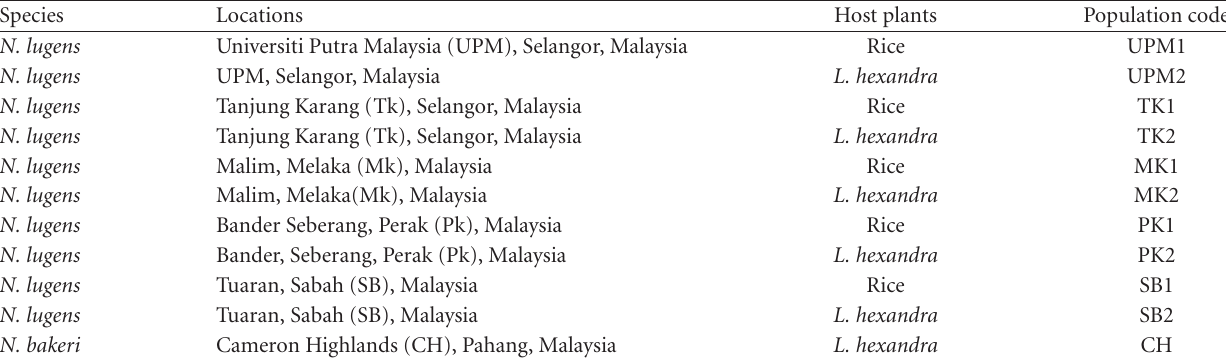
Table 1: Host types, sites of collection, and coding for 11 populations of Nilaparvata spp. Species